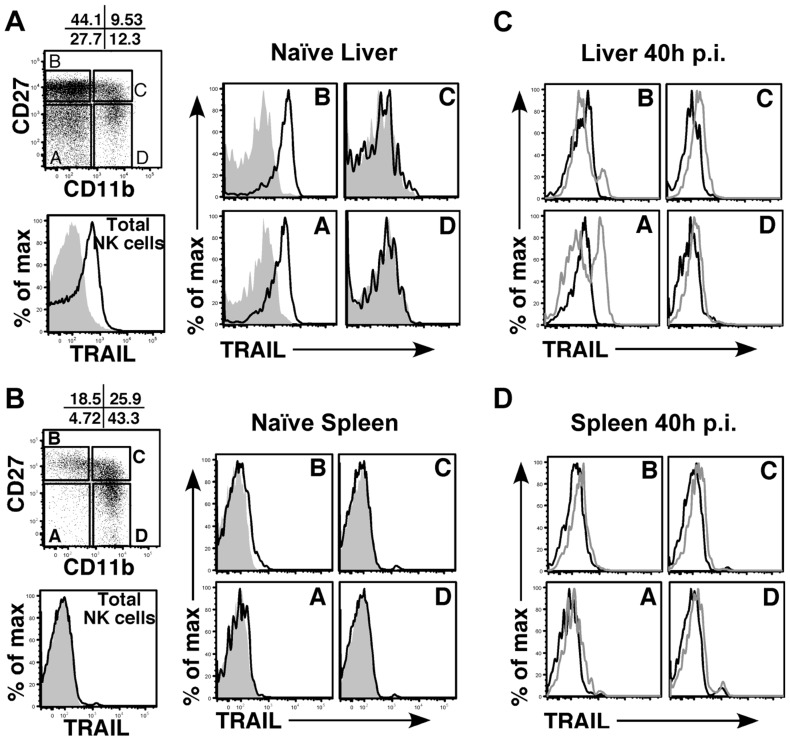
Immature liver NK cells express high TRAIL levels.Surface TRAIL expression on liver (A) and spleen (B) NK cell subsets in naïve BALB/c mice was examined by FACS. TRAIL expression on ‘total’ NK cells is shown as the black histogram. NK cells were analyzed for expression of CD27 and CD11b and subdivided into 4 maturational subsets (A–D), as shown in the dot plot. Surface TRAIL expression on the four NK subsets (black, TRAIL; gray, isotype) was analyzed. (C, D) Surface TRAIL expression was assessed on liver (C) and spleen (D) NK cell subsets 40 h after infection with WT MCMV (gray histogram). Surface TRAIL expression from naïve BALB/c mice (black histogram) is included. Results are representative of 3 mice per group from a minimum of two independent experiments.